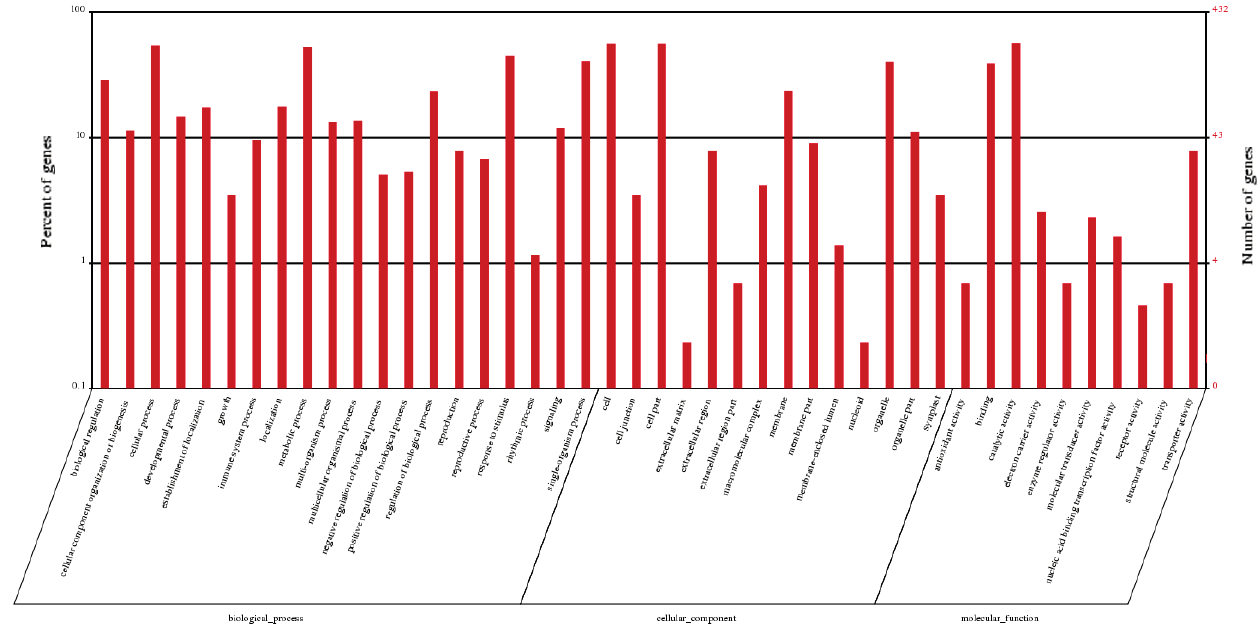
Figure 5. GO classifications of differentially expressed